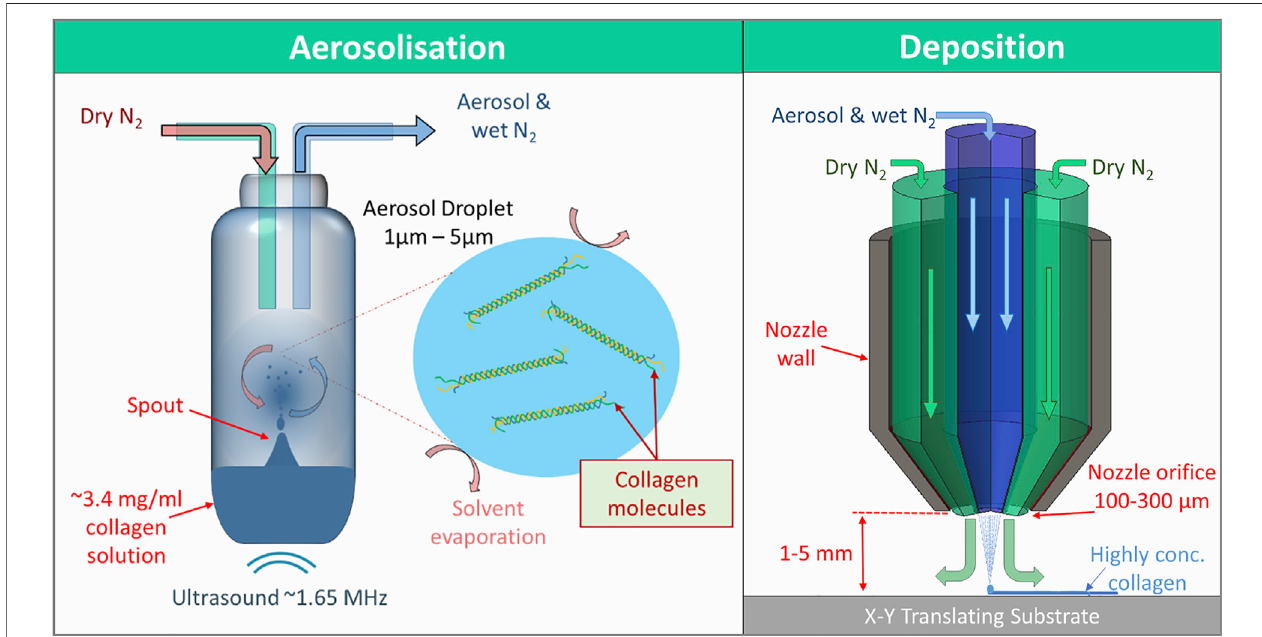
FIGURE 1 | The two major steps of aerosol jet printing. Firstly, aerosolization, where 1.65 MHz ultrasound generates a standing wave within the ink reservoir resulting in the formation of a spout, the surface of which resonates and disperses aerosol-sized ( < 5 µm diameter) droplets of ink. The droplets then mix and become entrained with a fl ow of nitrogen gas through the reservoir towards the deposition head. Secondly, in the deposition head, the aerosol-laden nitrogen is collimated by a secondaryannular fl owofnitrogen,separatingtheaerosol fl owfromthewallsofthenozzle.Theaerosoldropletsthencoalesceonanx-ytranslatingprintsubstrate. Thecollimationoftheaerosolcontinuesforup5 mmafterthenozzle.Thehighsurfaceareatovolumeratiooftheaerosoland fl owofdrynitrogengasallowstheinktodry very quickly in transit and on the substrate resulting in highly concentrated printed collagen.